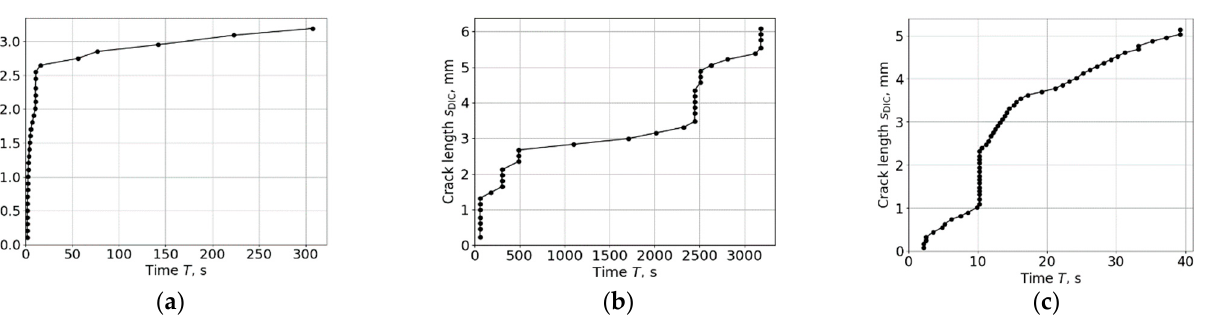
Figure 7. Field of crack maximum normal strain ( upper row ) and temporal dependencies of the calculated crack length ( lower row ) for rail ( a ), wheelset ( b ), and traction clamp ( c ) samples.